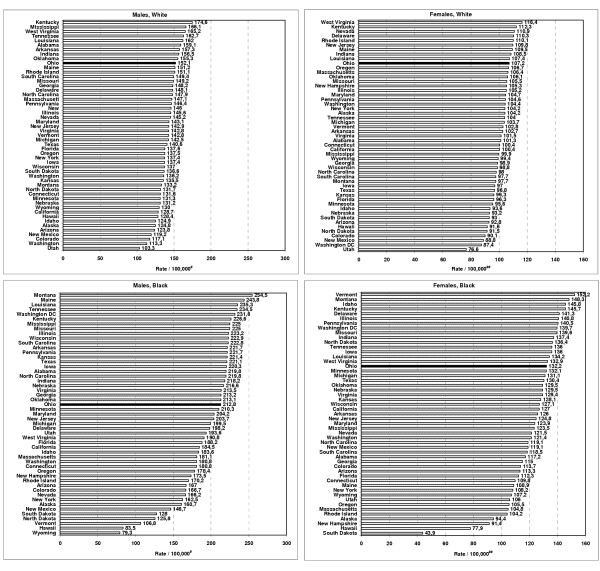
Cancer mortality in the USA, 1997–2001, by state, gender and race # – Age-adjusted mortality rates (World Standard Population).